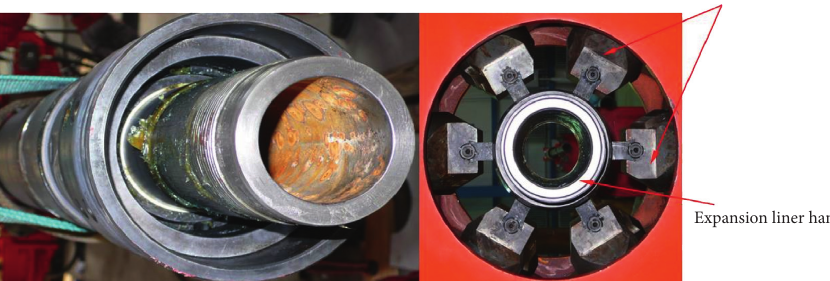
Figure 21: Expansion liner hanger supported with the experimental dismounting frame and kept it in a horizontal position.